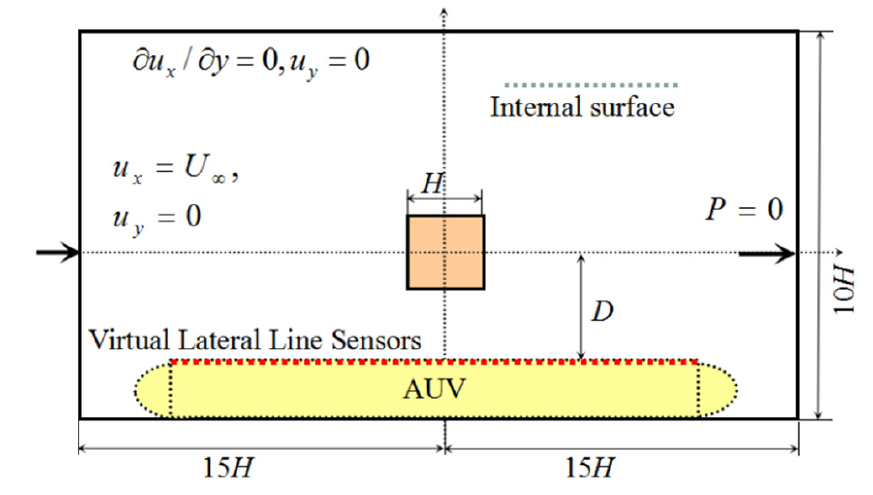
Figure 1. Schematic diagram of the computational domain for a square target. In the numerical scheme, the two-step Taylor characteristic-based Galerkin (TCBG) method was used to solve the flow governing equation, which was presented by Bao et al. [48]. The progress of the TCBG scheme for the momentum equations is shown in flowing equations. The accuracy of the numerical scheme was validated previously [49]. The Strouhal numbers S t of the square target with different postures θ was computed, as shown in Figure 2. The results were in accord with previous reports, and the computational algorithm was adequate to solve the flow field around the underwater